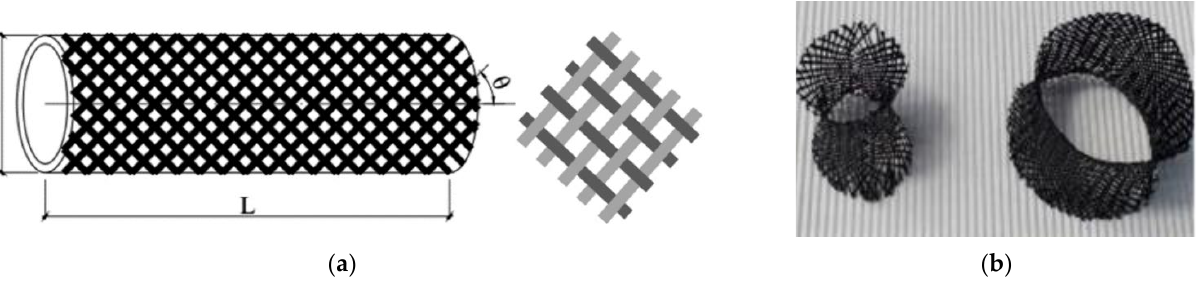
Figure 8.(a) Textile structure of braided tubular fabric and (b) schematic diagram of the weave of Figure 8. ( a ) Textile structure of braided tubular fabric and ( b ) schematic diagram of the weave of carbon fiber tube [27]. carbon fiber tube